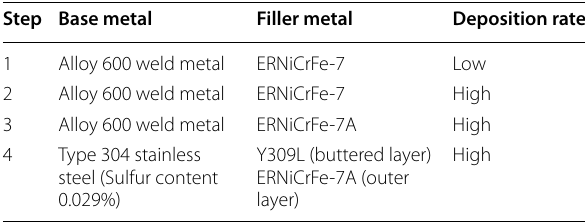
Table 1 Experimental conditions of the underwater laser